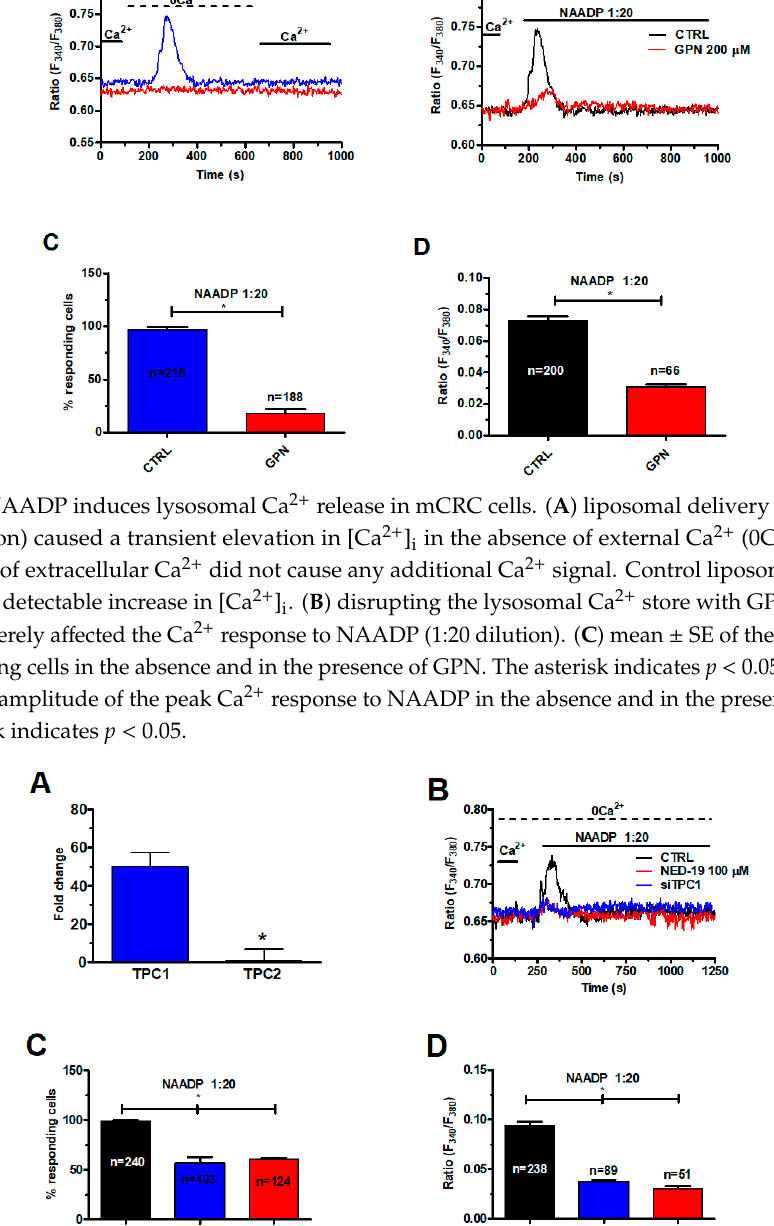
Figure 5. Two-pore channel 1 (TPC1) mediates NAADP-induced lysosomal Ca 2+ release in mCRC cells. ( A ) qRT-PCR analysis of TPCs revealed that TPC1 transcripts are more abundant as compared to those encoding for TPC2. Data are expressed as Fold change (mean ± SE) of qRT-PCR runs performed in triplicate. The asterisk indicates p < 0.05. ( B ) the Ca 2+ response to liposomal delivery of NAADP (1:20) NAADP was inhibited by NED-19 (100 µM, 30 min), a selective TPC inhibitor, and by the genetic silencing of TPC1 by a specific siRNA. ( C ) mean ± SE of the percentage of responding cells under the designated treatments. The asterisk indicates p < 0.05. ( D ) mean ± SE of the amplitude of the peak Ca 2+ response to NAADP under the designated treatments. The asterisk indicates p < 0.05.